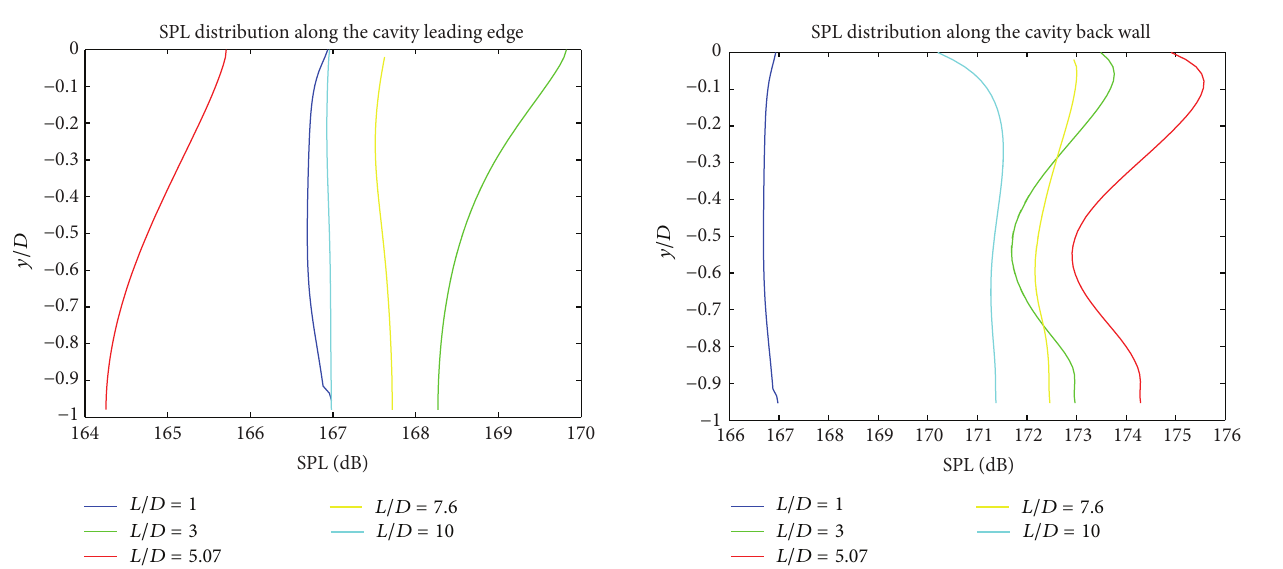
Figure 7: SPL distribution along the cavity back wall.